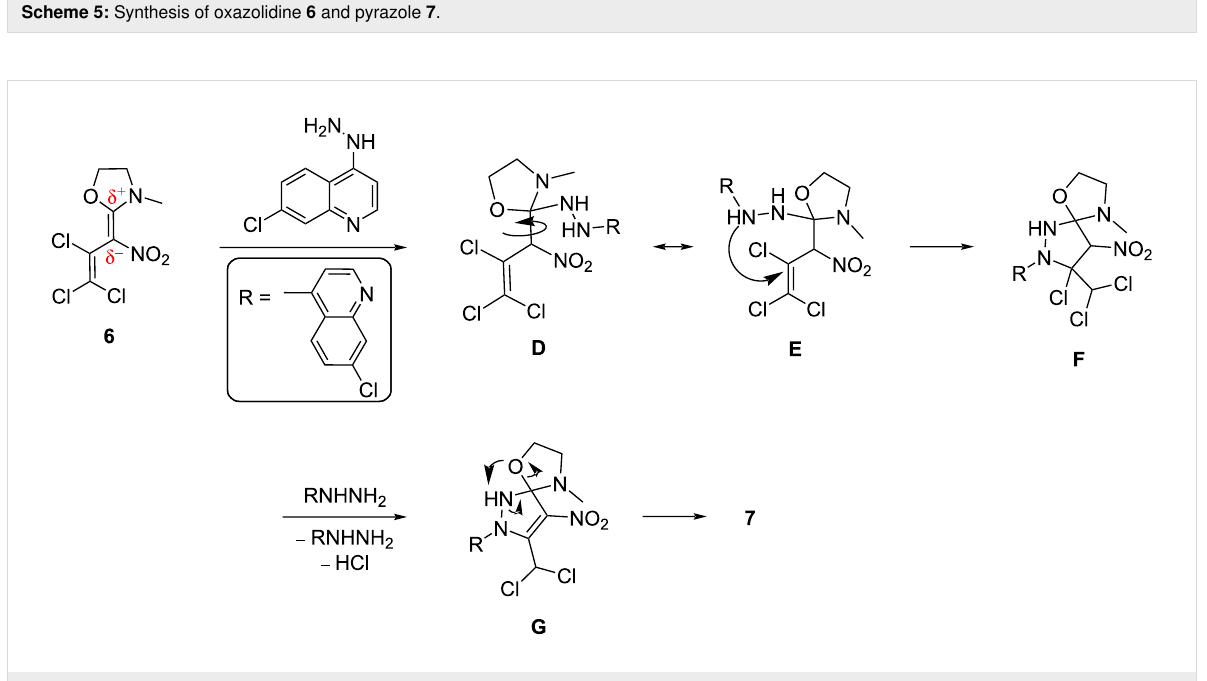
Scheme 6: A plausible mechanism for the formation of pyrazole 7